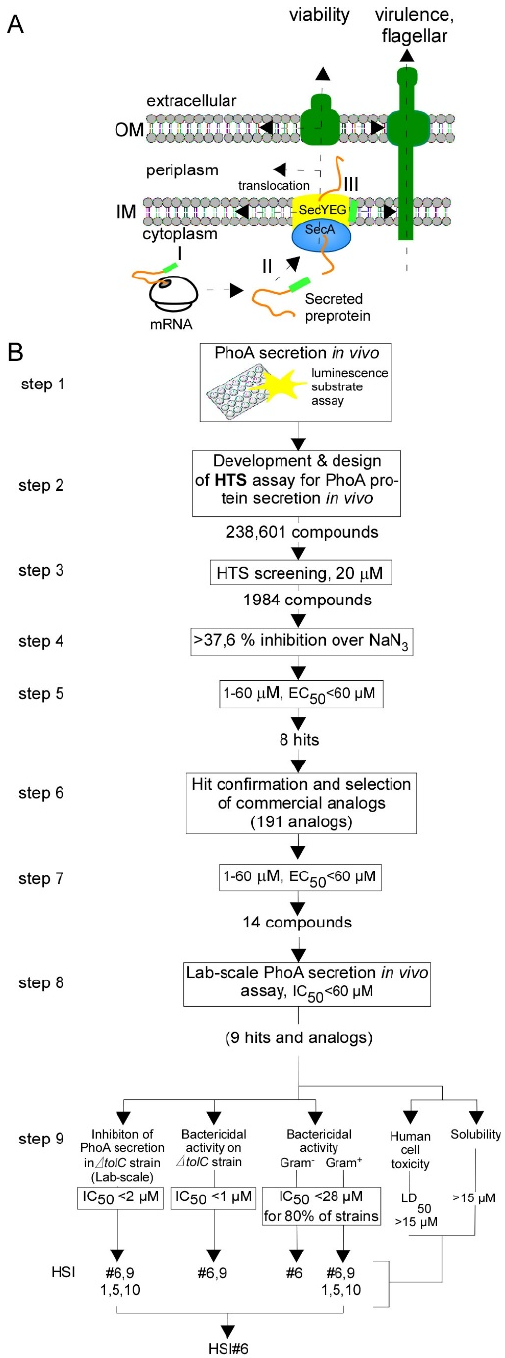
Figure 1. Overview of Sec pathway and HTS pipeline to discover anti-protein secretion. ( A ). Cartoon of the Sec pathway in a cell. ( B ). HTS and screening pipeline used for the identification and characterization of secretion inhibitors.